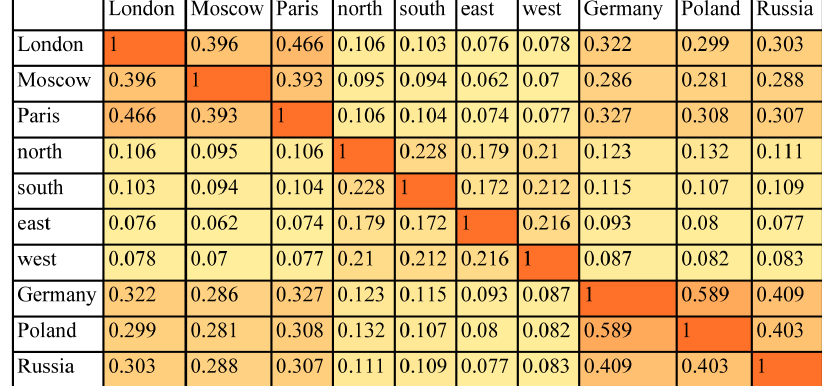
Figure 2. Semantic similarity matrix (shown as a heat map) derived from WordNet for the set of words { London,Moscow,Paris,north, south,east,west,Germany,Poland,Russia } using senses relevant to the geography of Europe.